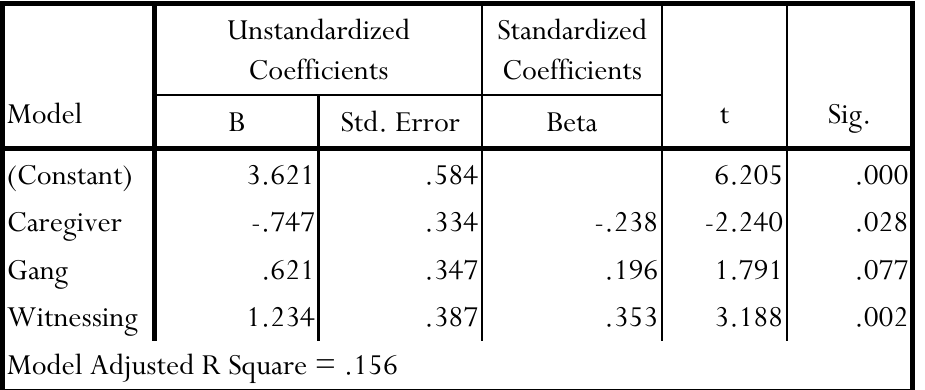
Table 18: Linear Regression of Number of Victimizations on Duration of Fighting Unstandardized